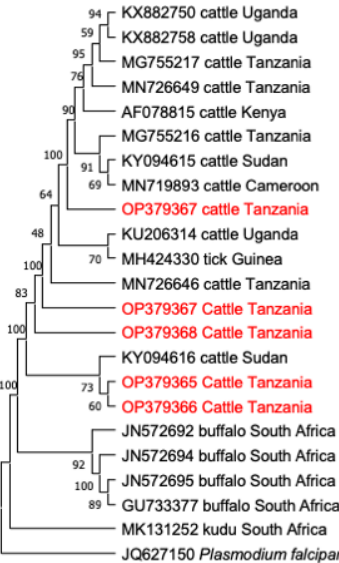
Figure 5. The phylogenetic analysis of Theileria mutans identified in this study, based on the ( 18S rRNA ) gene. The tree was constructed by MEGA version 11 using the maximum likelihood method, the confidence of occurrence of the nodes was assessed by bootstrap in 1000 replications. The sequences of this study are shown in red. Plasmodium falciparum (JQ627150) was used as an outgroup.